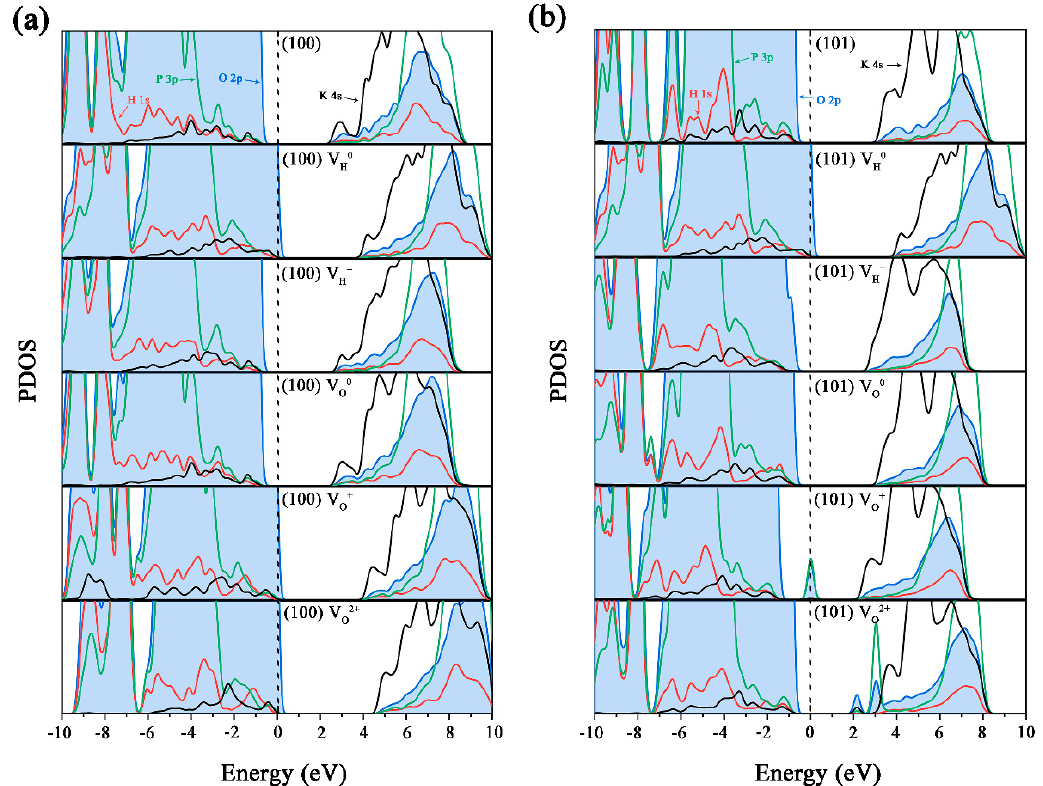
Figure 3. Partial density of states of the V H and V O defects on the (100) ( a ) and (101) ( b ) surfaces, respectively.